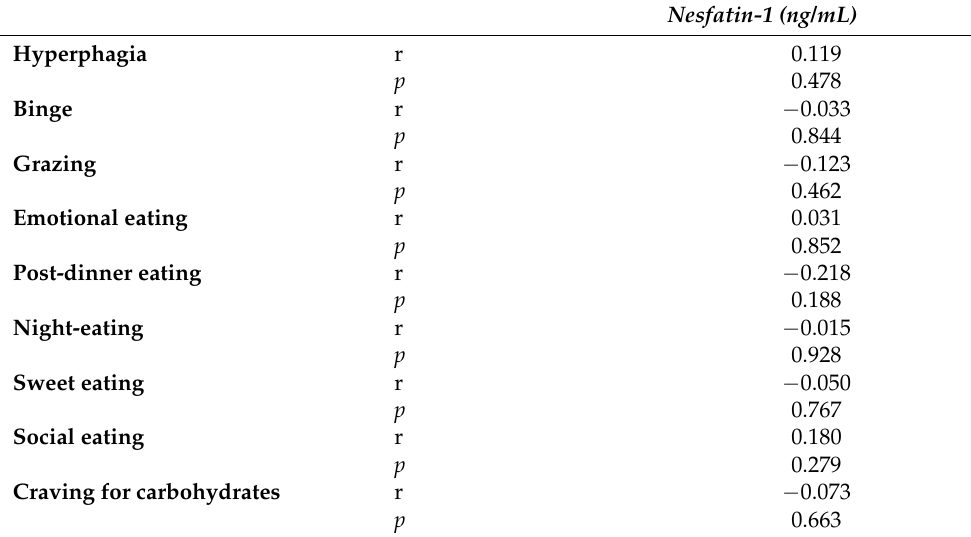
Table 3. Correlations between nesfatin-1 and eating behaviors.